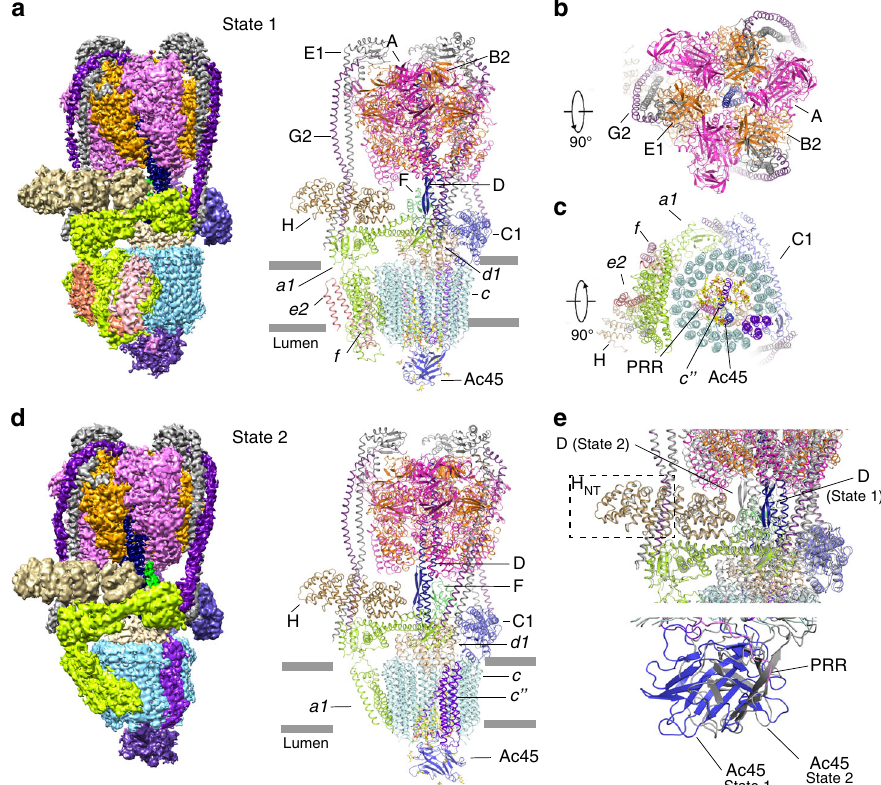
Fig. 1 Overall structure of V-ATPase from bovine brain. a Overall cryo-EM map and structure showing V-ATPase in state 1 viewed from the side of the membrane. b The cytosolic view of the V-ATPase. c The luminal view of the V-ATPase. d Overall cryo-EM map and structure showing V-ATPase in state 2. Each subunit is colored and indicated. e The structural comparison of the two